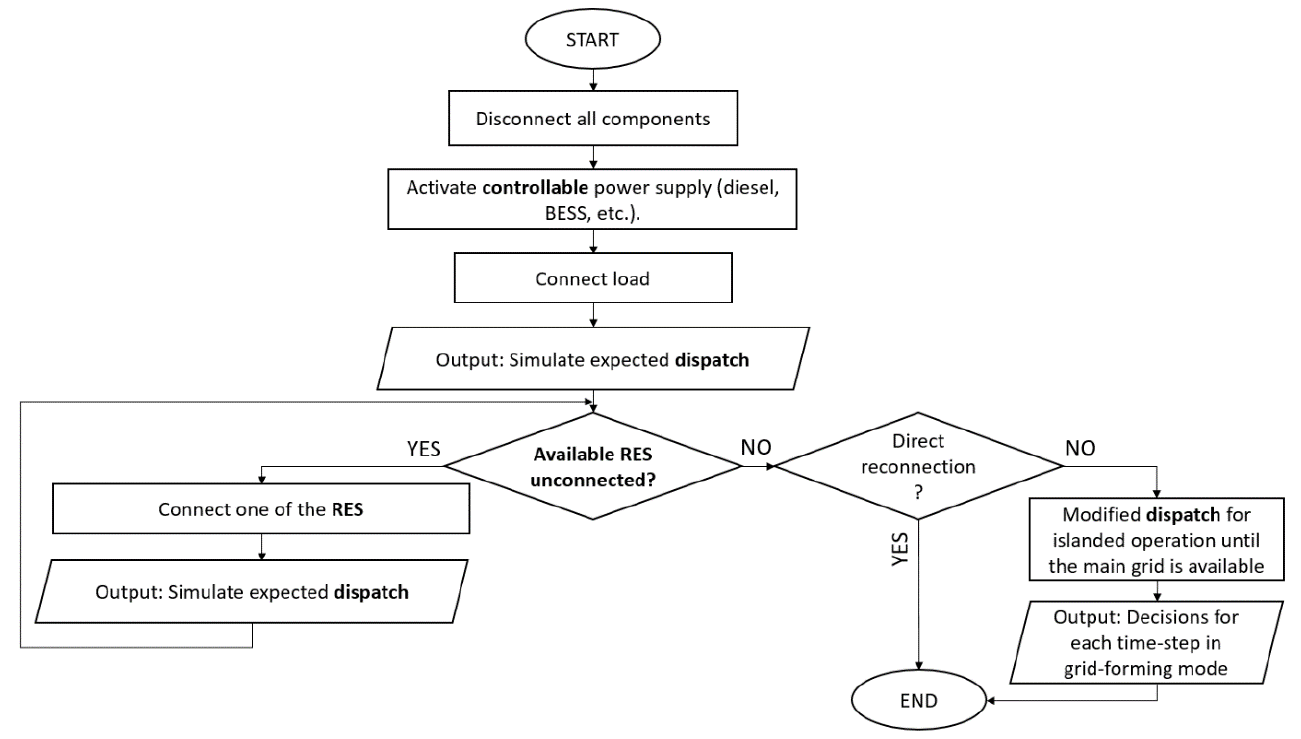
Figure 3 . Black start flow chart. Figure 3. Black start flow